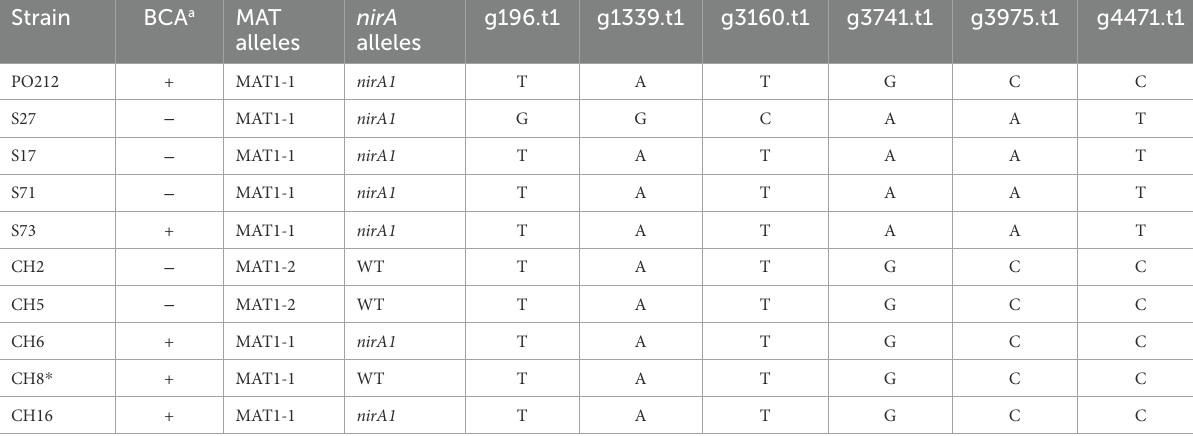
TABLE 6 Nucleotide variations and alleles in loci of Penicillium rubens strains from INIA, CSIC collection. Strain BCA a